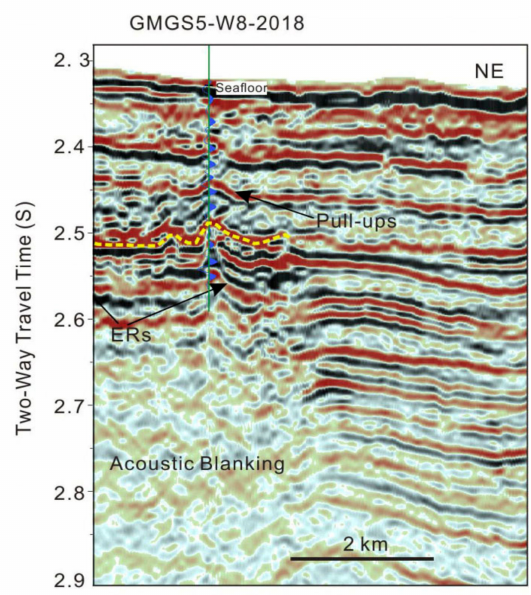
Figure 7. Pseudo-3D seismic profiles showing the characteristics of the bottom simulating reflector (yellow line: BSR) and mass transport depositions (MTDs) at site GMGS5-W08-2018